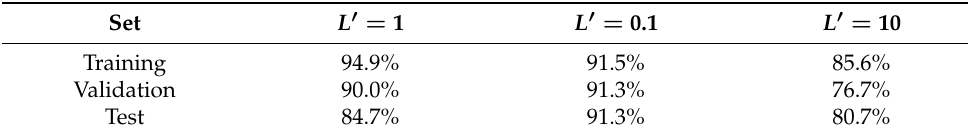
Table 2. Sensor fault diagnosis accuracy levels for each data